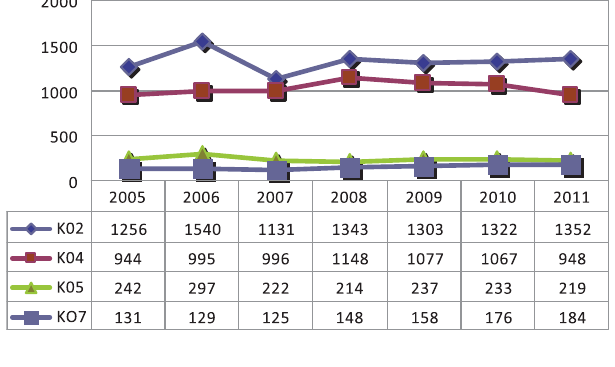
FIGURE 2. Number of dentofacial anomalies and number of removable orthodontic applianc- es recorded in time period 2005 to 2011. The fi gure shows increased number of dentofacial anomalies during the time period from 2005 to 2011. This trend can be considered one of the reasons for the increased number of removable orthodontic appliances recorded in the same period.